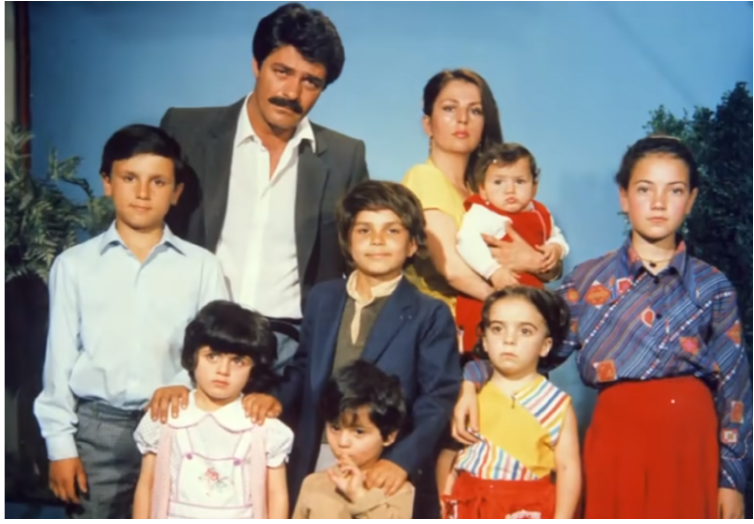
Figure 6: At the end of the film, Cemal (Kadir Inanir) and Aygül (Hale Soygazi) get